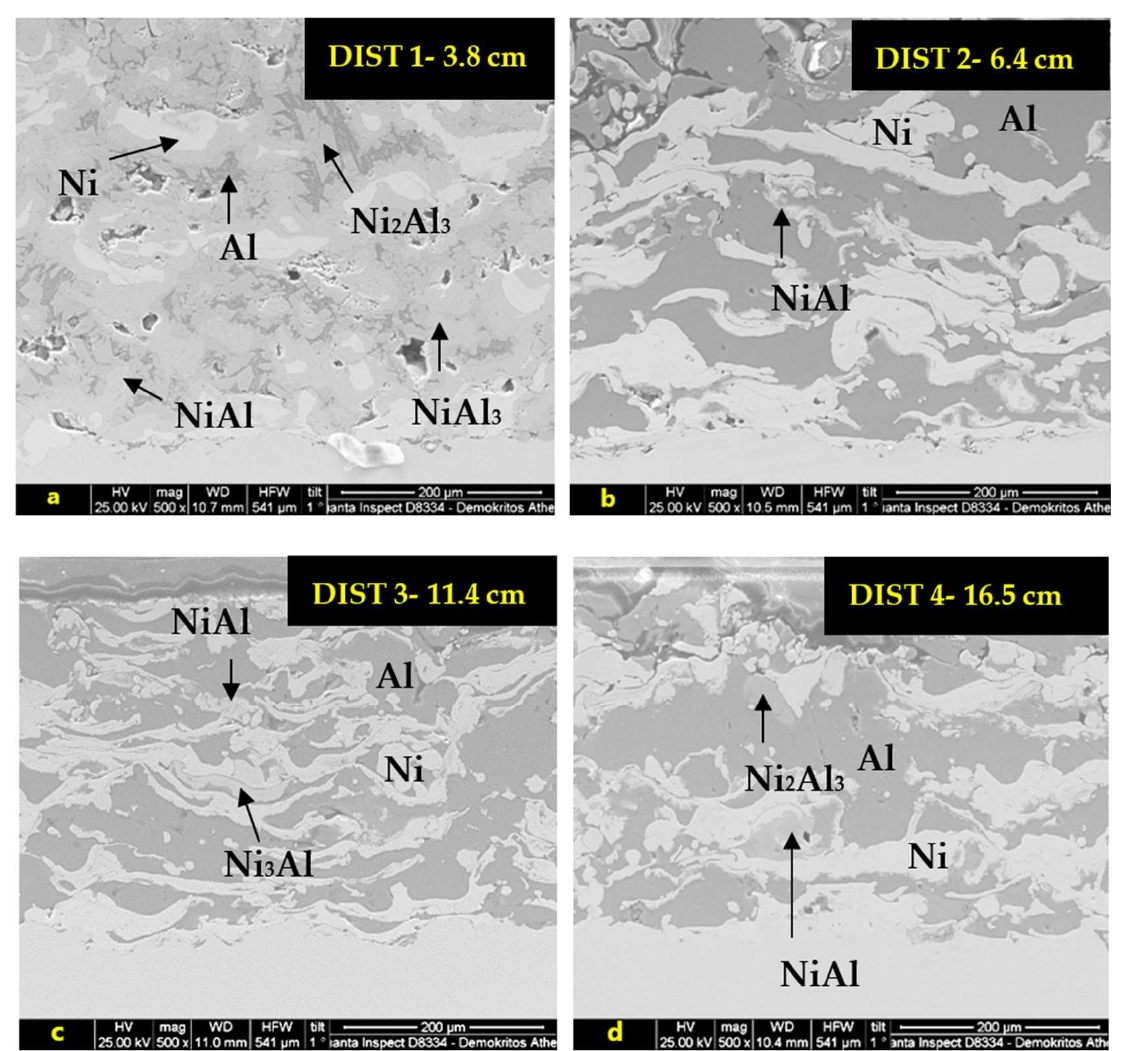
Figure 3. SEM (SE mode) micrographs of the cross-sections of the coatings produced at various thermal spraying distances: ( a ) 1.5 inch (3.8 cm): DIST 1, ( b ) 2.5 inch (6.4 cm): DIST 2, ( c ) 4.5 inch (11.4 cm): DIST 3 and ( d ) 6.5 inch (16.5 cm): DIST 4 and phase identification by EDX.